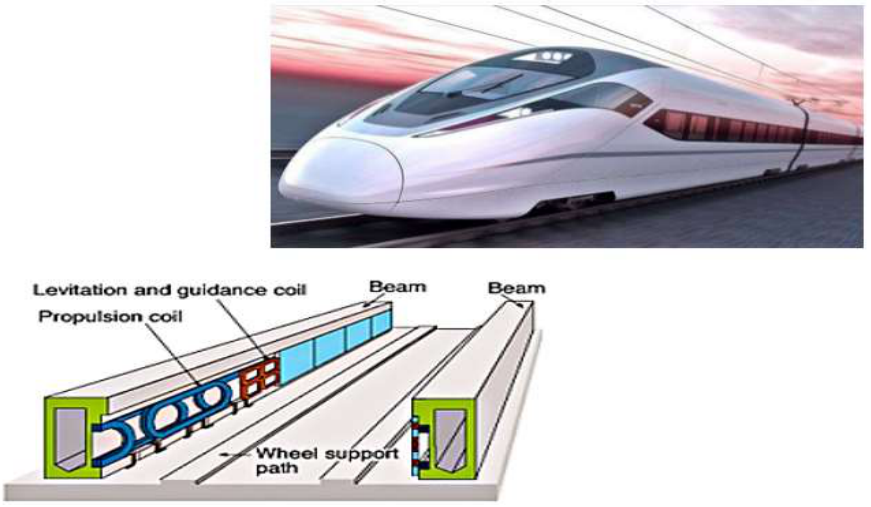
Figure 7: Sketched & Photographed of Magnetic Levitation